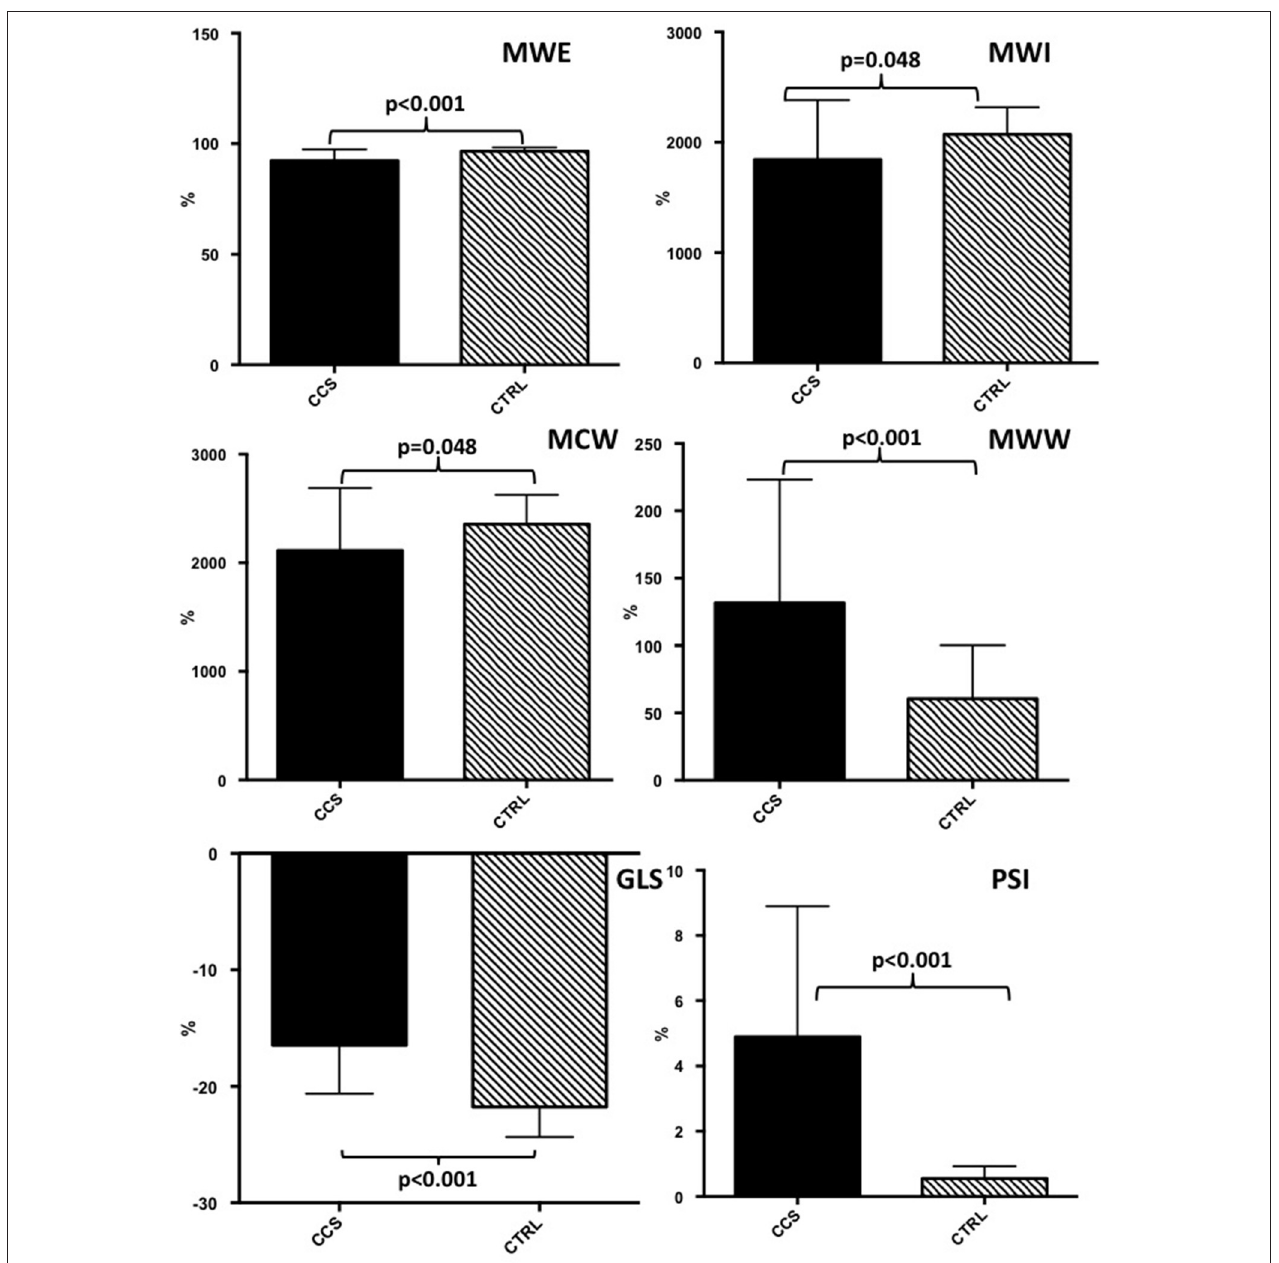
FIGURE 1 | Baseline echocardiographic evaluation of myocardial work indices and global longitudinal strain in patients with critical coronary stenosis compared to healthy controls. CAST, critical coronary stenosis; CTRL, controls; GLS, global longitudinal strain; MWI, myocardial work index; MCW, Myocardial Constructive Work; MWW, Myocardial Wasted Work; MWE, Myocardial Work